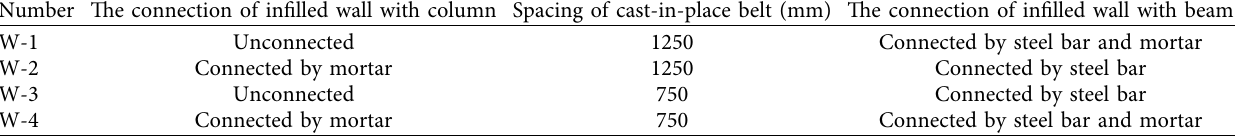
Table 2: Types of masonry